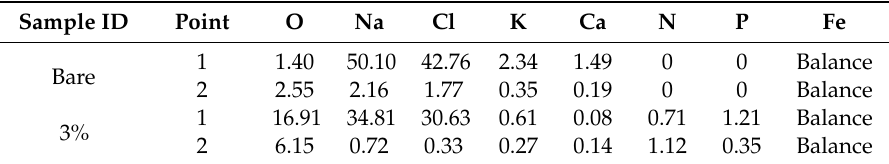
Table 4. EDS of steel rebar sample after 120 h of exposure in bare and 3% inhibitor-containing SCP + 3.5 wt% NaCl